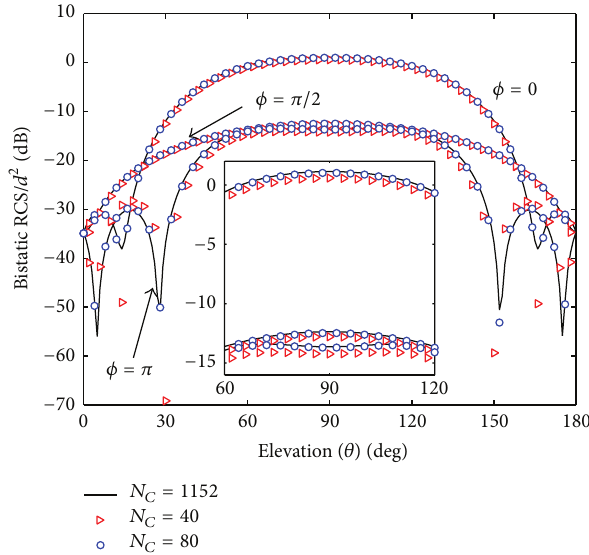
Figure 6: For convergence study, bistatic RCS of a linear arrange- ment of four dielectric spheres (see Figure 5) for increasing number 𝑁 𝐶 of coupled eigencurrents. Inset: closeup of the RCS. Data : ̂ z exp (−𝑗2𝜋𝑓𝑥/𝑐 ) V/m, 𝑓 = 1GHz. 0